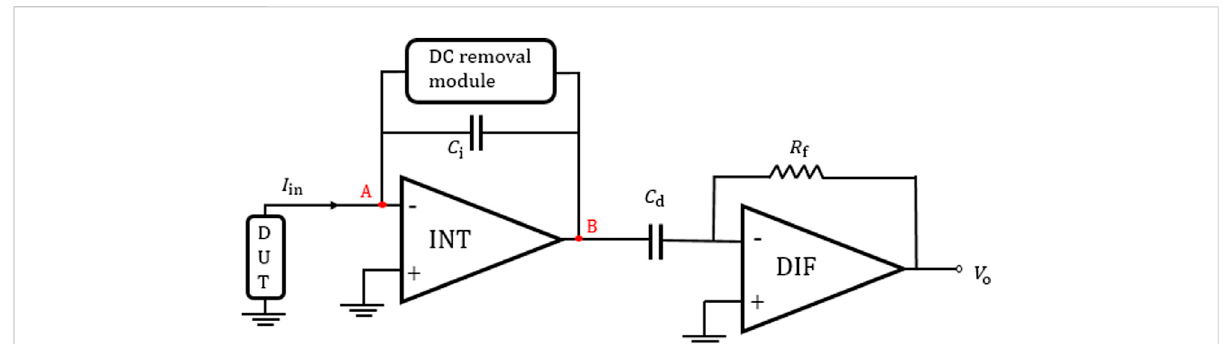
FIGURE 8 Integrator – differentiator structure without continuous-time feedback network (Singh et al.,